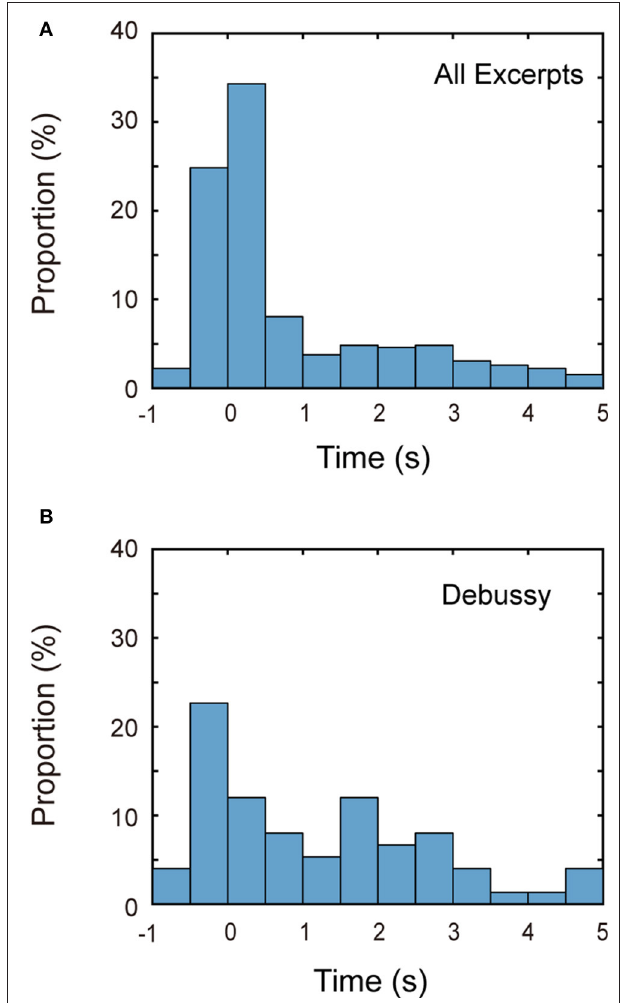
timing of the first expiration after 500 ms before the music onset is plotted. The first expiration is concentrated on just after the music onset. (B) Histogram for Excerpt J is shown. The distribution is apparently broader than the other musical